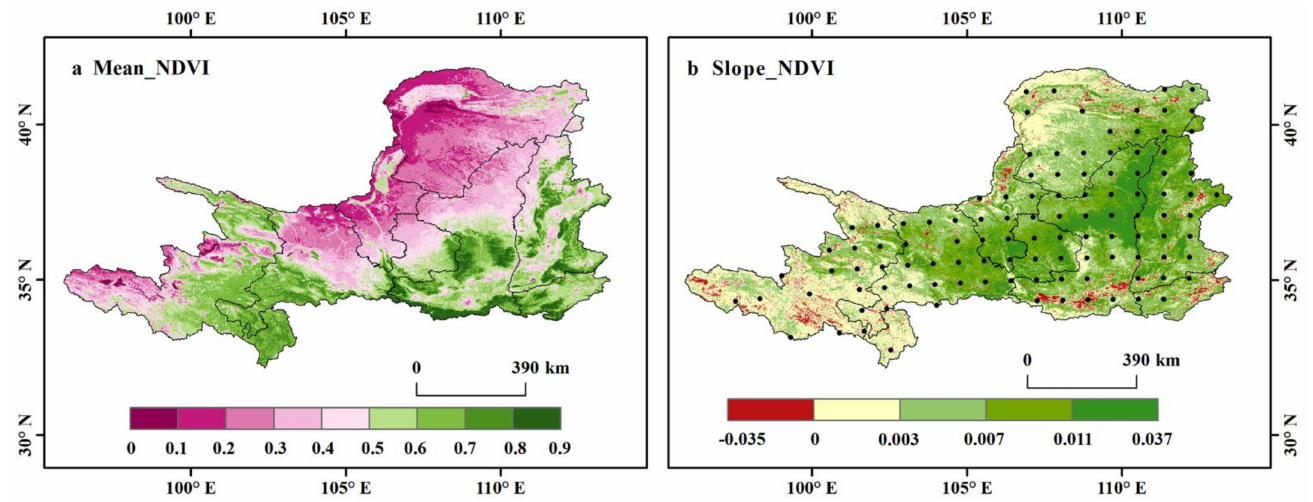
Figure 2. Spatial distribution of the mean NDVI ( a ) and inter-annual variation rate (slope) ( b ) during the growing season in the upper and middle reaches of the Yellow River basin from 2000 to 2019. Black dots indicate statistically significant correlations at the 95% confidence level. Same